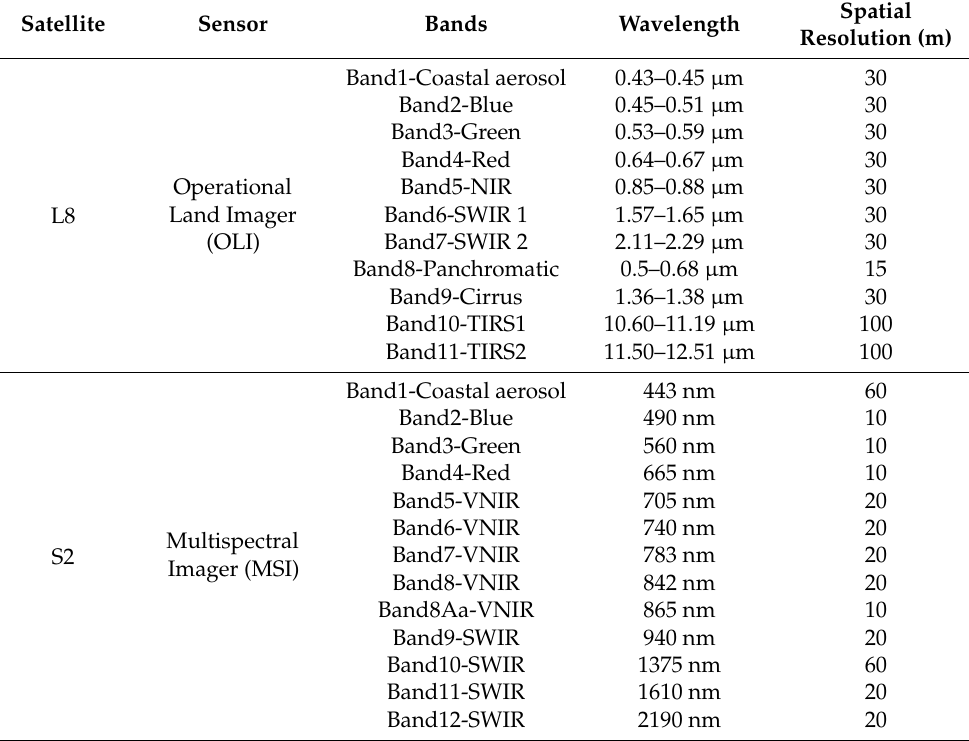
Table 1. Corresponding Landsat 8 (L8) and Sentinel 2 (S2) bands and spatial